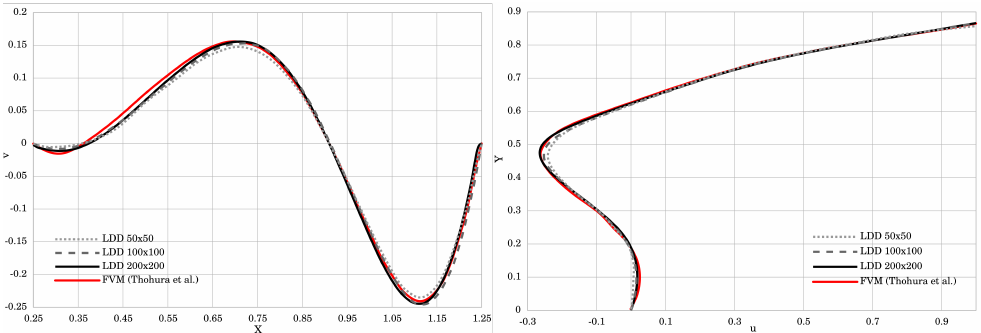
Figure 6. The velocity profile along the horizontal and vertical centerline of the skewed lid-driven cavity test.